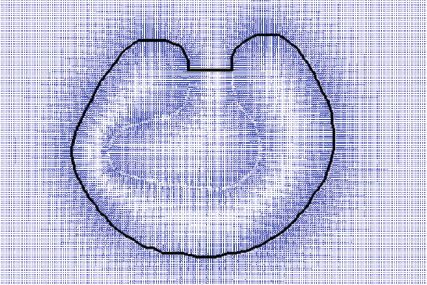
Figure 2: External force field of GVF and stopped active